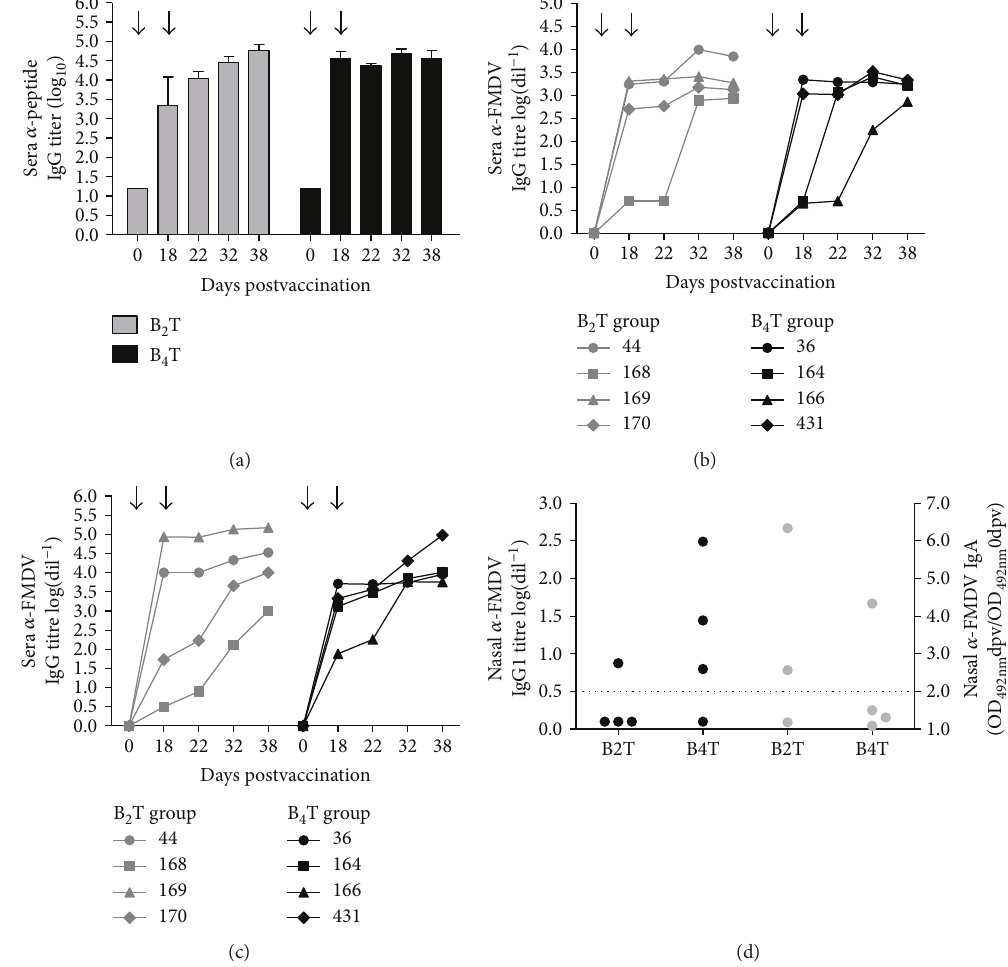
Figure 2: Antibody detection by ELISA in vaccinated cattle. Animals were immunized on days 0 and 18 (arrow) with B Kinetics of anti-peptide serum antibodies. Bars represent the mean IgG titres from bovines in each group (gray, B the experiment (error marks, SD). (b, c) Kinetics of total IgG and IgG1 anti-FMDV O1/Campos/Bra/58 serum antibodies. Titres were calculated as log of the last reciprocal dilution above cut-o ff . Data points represent the IgG titre (b) or IgG1 titre (c) from each animal 10 represented by di ff erent shapes (right legend) throughout the experiment. (d) FMDV-speci fi c mucosal IgG1 and IgA responses. Nasal swabs were collected at 22 dpv. Each point represents the nasal IgG1 anti-FMDV antibody titres (log O1/Campos/Bra/58 antibody level of each animal. The cut-o ff was established as the mean value of mock-vaccinated animals plus twice the SD value (dotted